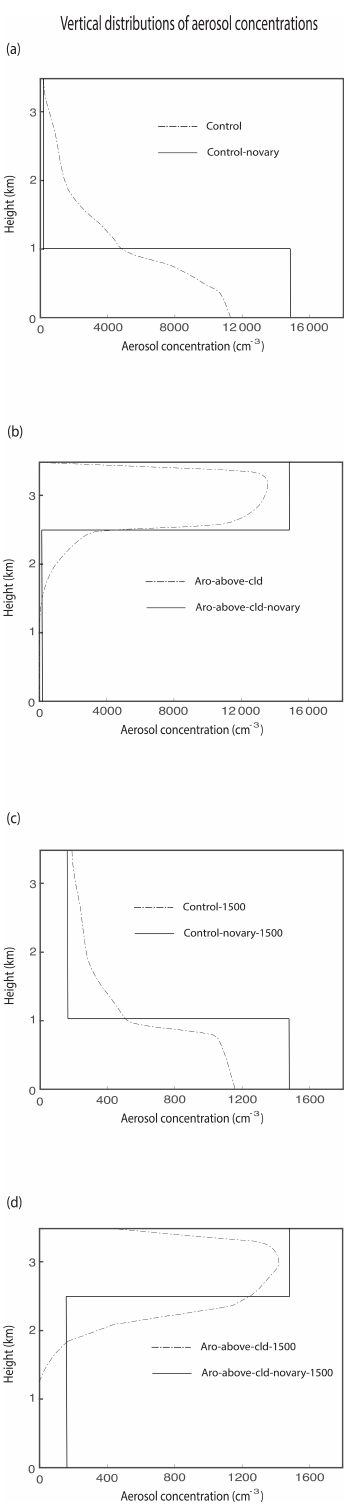
Figure 10. Vertical distributions of the time- and area-averaged aerosol concentrations (a) in the control and control-novary runs, (b) aro-above-cld and aro-above-cld-novary runs, (c) control-1500 and control-novary-1500 runs, and (d) aro-above-cld-1500 and aro- above-cld-novary-1500 runs.